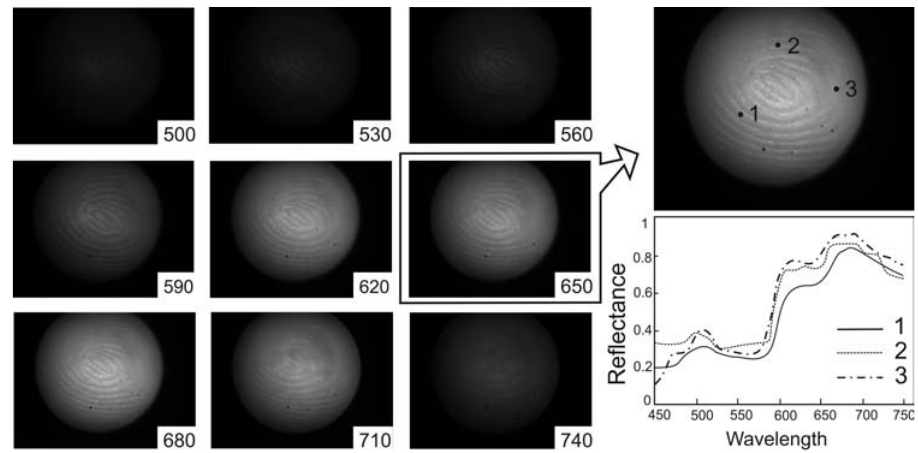
Fig. 4. Spectral images (500 – 740 nm) of human skin (thumb) and measured re°ectance spectra at three di®erent